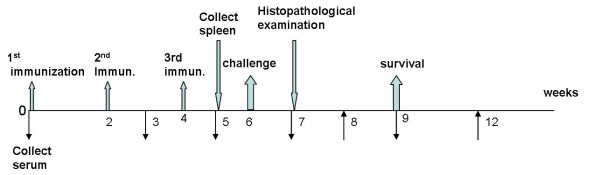
Experimental design.